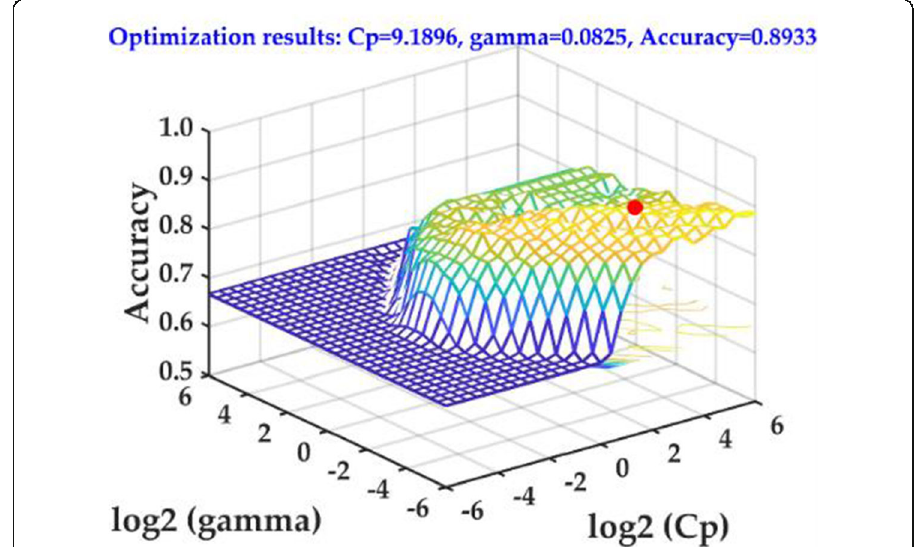
Fig. 12 Optimization of searching penalty coefficient Cp and kernel function parameter gamma for feature subset r (1 : 8) using grid search